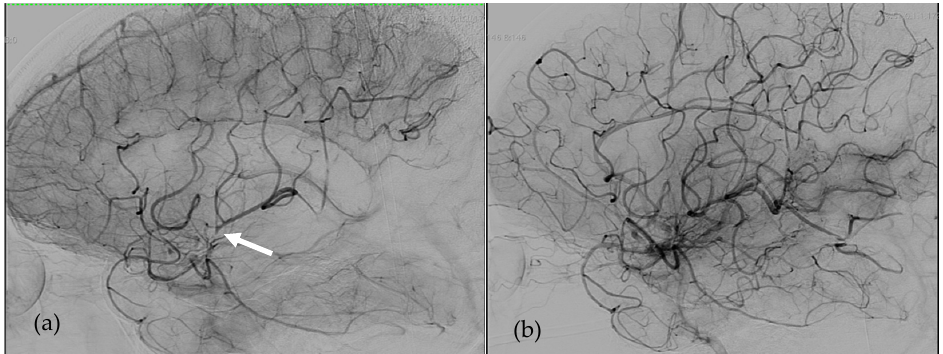
Figure 1. Angiographies of Left Internal Carotid Artery in patient 1. ( a ) Left Middle Cerebral Artery occlusion responsible for right hemiplegia just before revascularization (the white arrow shows the thrombus). ( b ) Early after endovascular revascularization by mechanical thrombectomy 100 min after the onset of the symptoms.